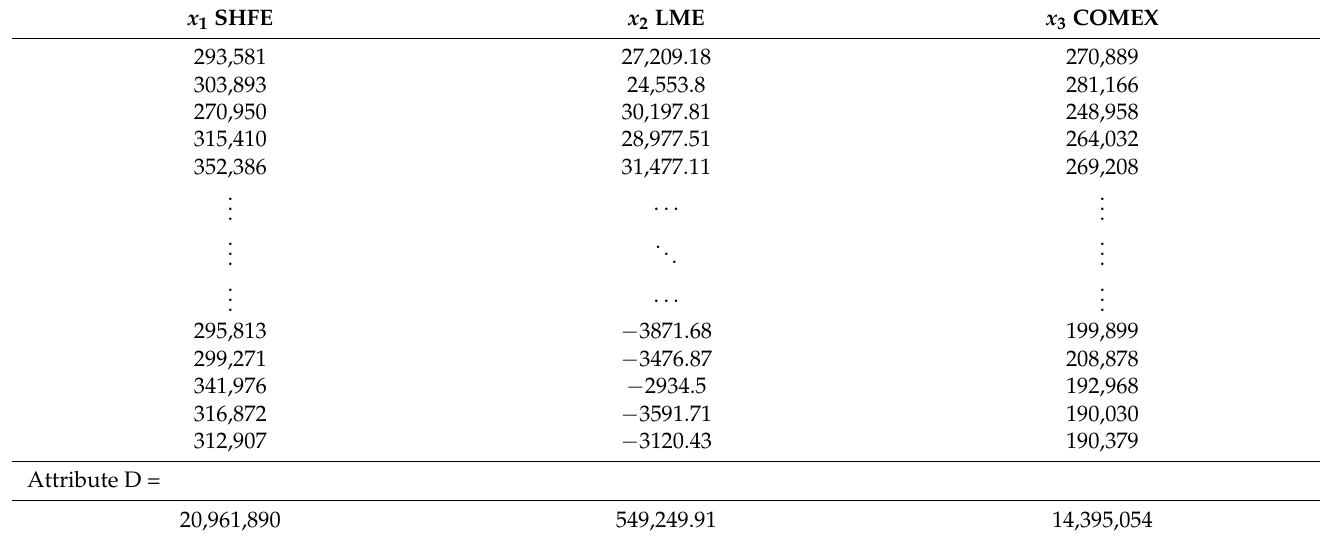
Table 11. Values of attribute “D” calculated using grey entropy and importing data from three copper futures markets after the COVID-19 outbreak.